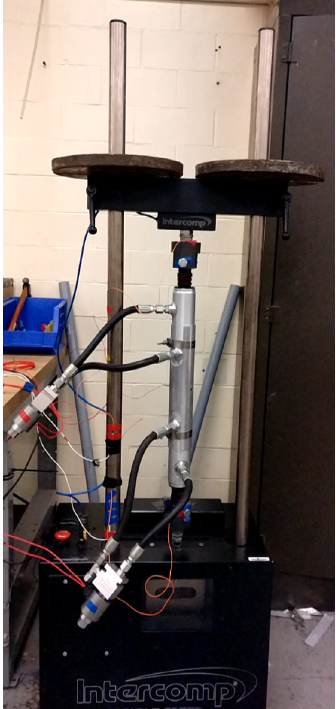
Figure 7. Application of Normal Load on the Shock Dyno.